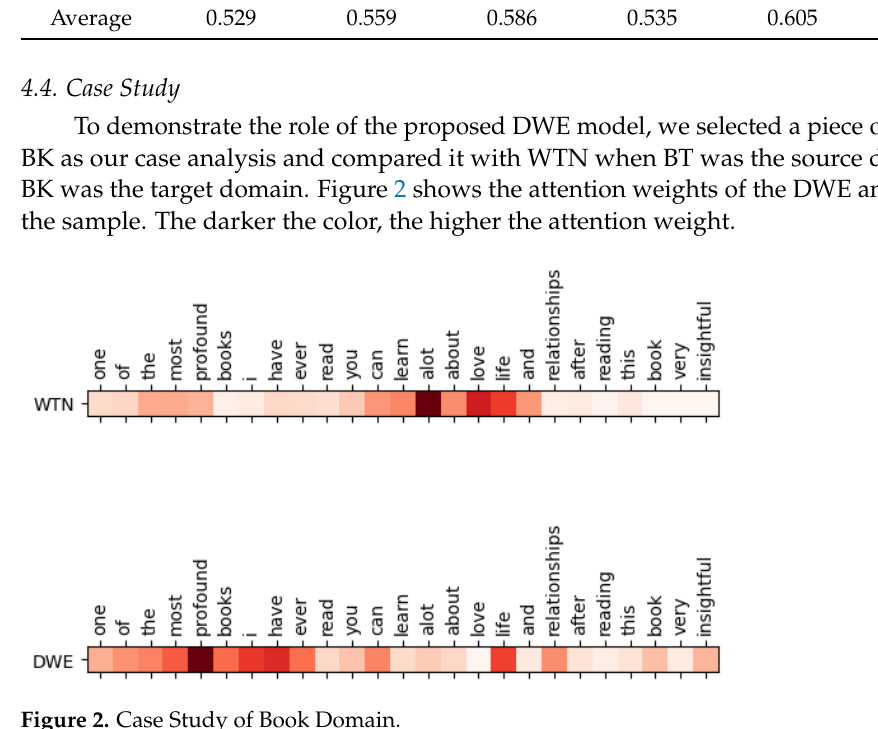
Figure 2. Case Study of Book